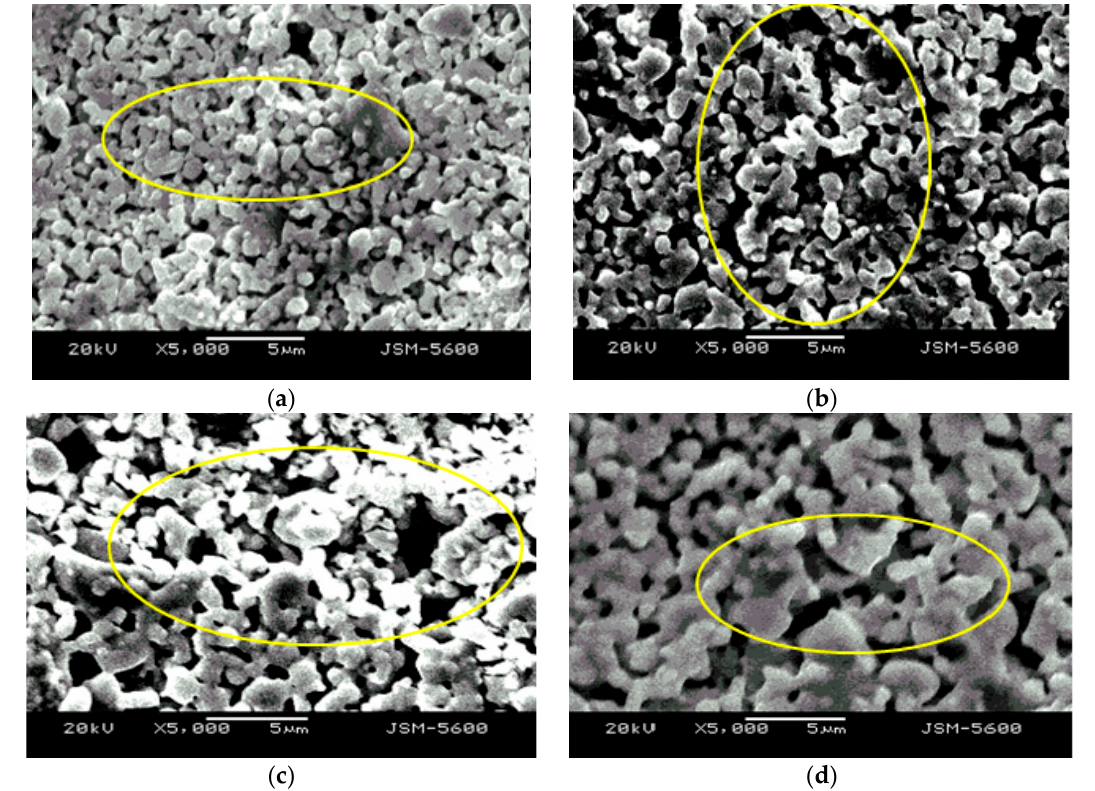
Figure 9. Series of SEM photographs of the cathode interface with various sintering temperatures: ( a ) 1100 °C; ( b ) 1150 °C; ( c ) 1200 °C; and ( d ) 1250 °C.